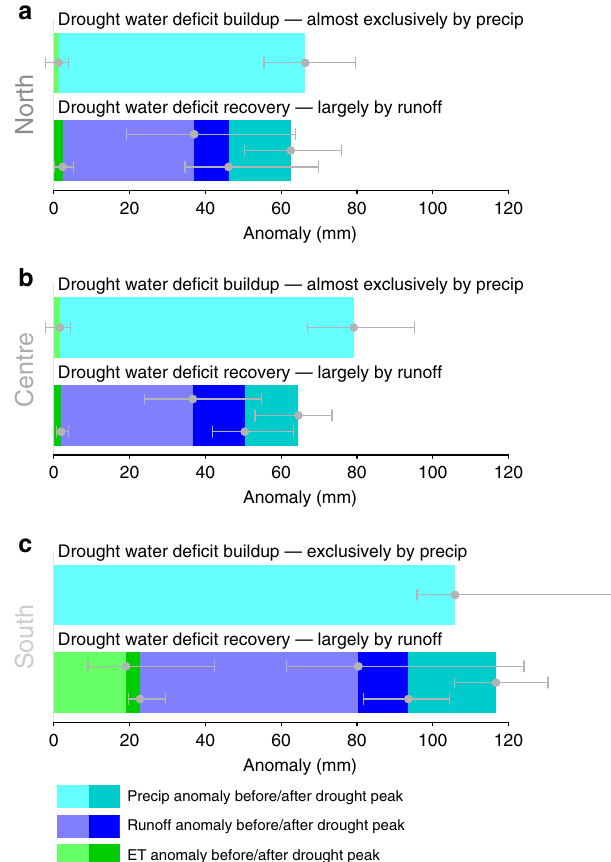
Fig. 4 Comparing drought-related precipitation, runoff, and evapotranspiration de fi cits. a - c Mean drought-related behavior of the major water-balance fl uxes (precipitation, runoff, ET) averaged across the ten strongest annual droughts and over all catchments in each European climate region. Error bars denote the inter-quantile range (25th – 75th percentile) across results from all catchments in the respective region